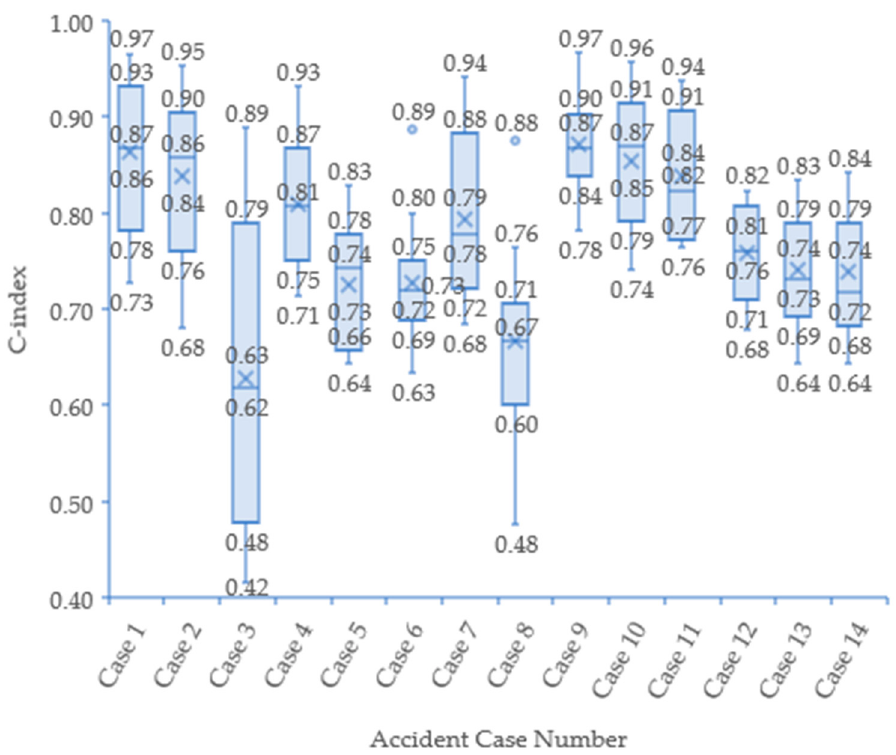
Figure 6. Data distribution of C-index calculation results among Group B. ‘ × ’ in the figure represents the average value.